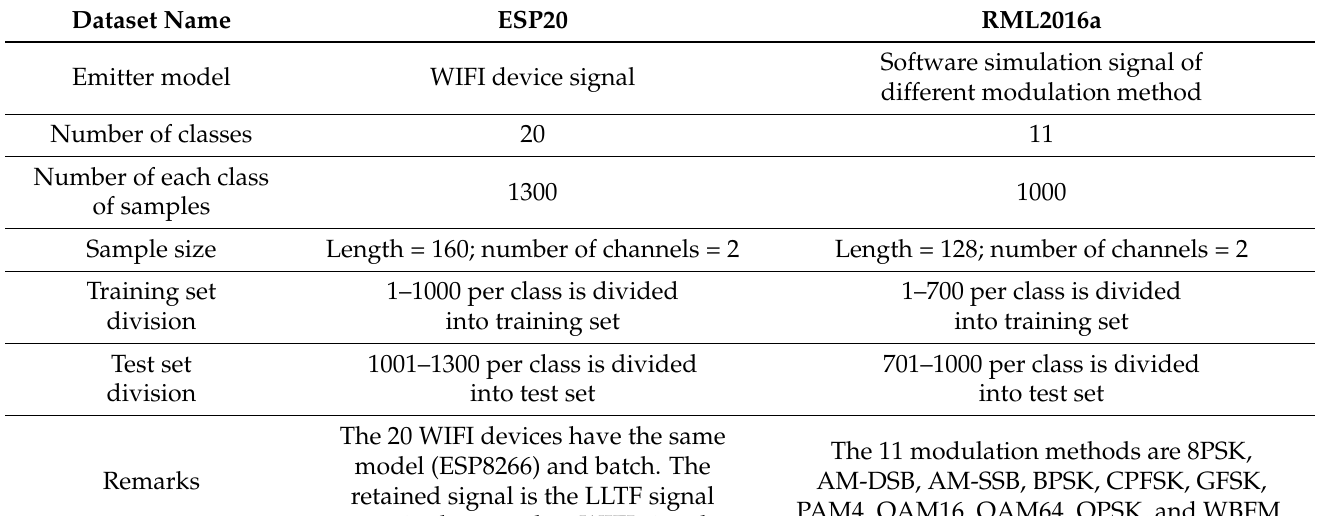
Table 1. Information summary of ESP20 dataset and RML2016a dataset.